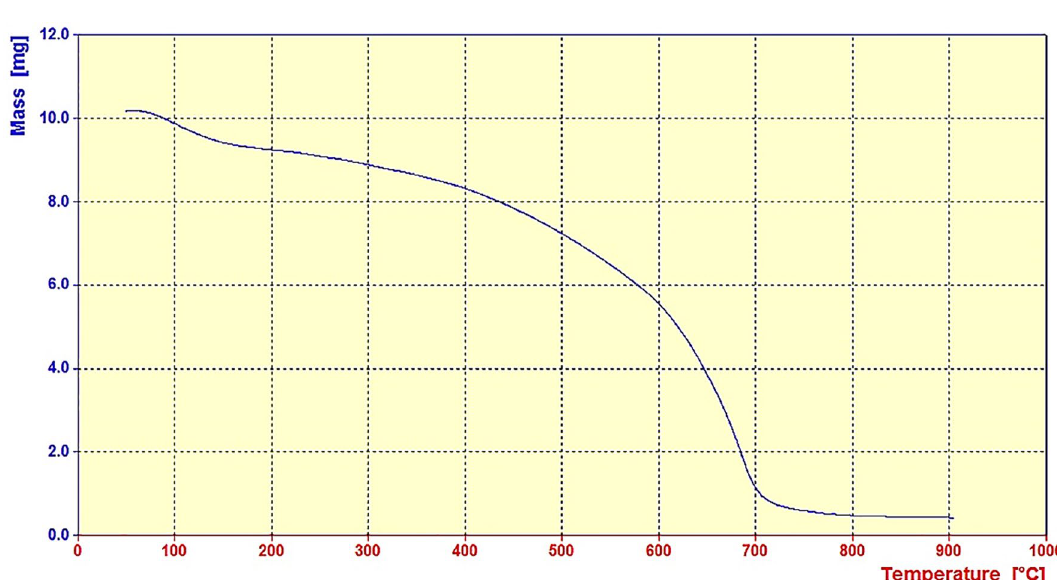
Figure 7. TGA analysis of g-C 3 N 4